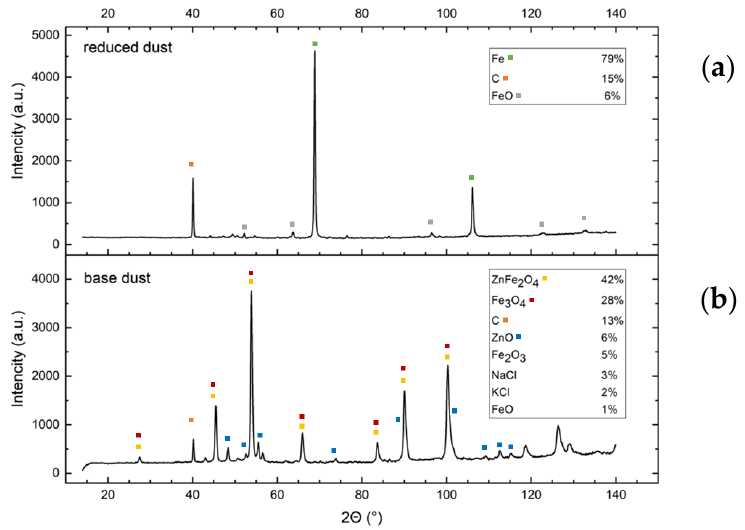
Figure 3. XRD data on reduced dust ( a ) and base dust ( b ) and with phase